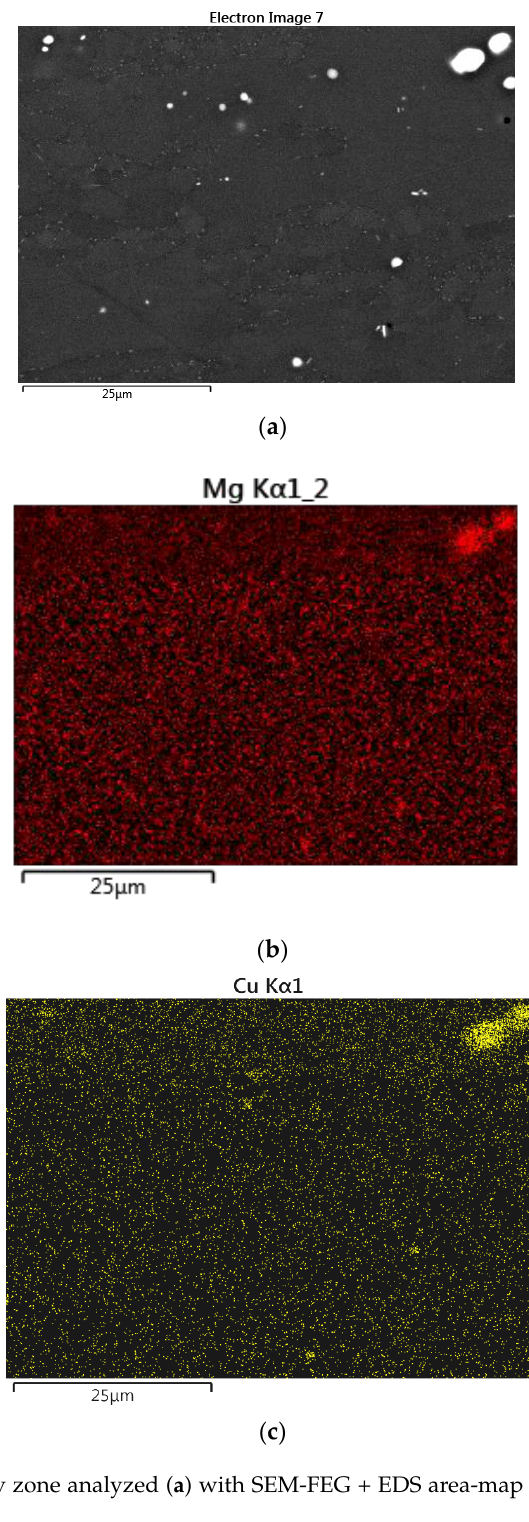
Figure 7. AA7050 alloy zone analyzed ( a ) with SEM-FEG + EDS area-map scanning of ( b ) Mg and ( c ) Cu.